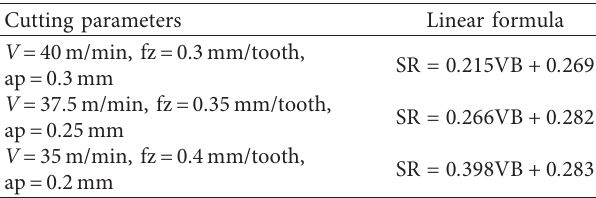
Table 4: Linear formula of tool wear on surface roughness, where SR is the surface roughness (Ra, μ m) and VB is the tool wear (mm). Cutting parameters Linear formula V � 40m/min, fz � 0.3mm/tooth, SR � 0 . 215VB + 0 . 269 ap � 0.3 mm